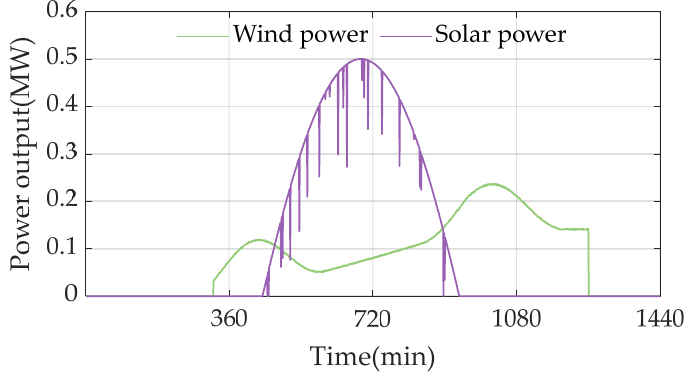
Figure 7. Renewable power output for hydrogen production in Scenario I.